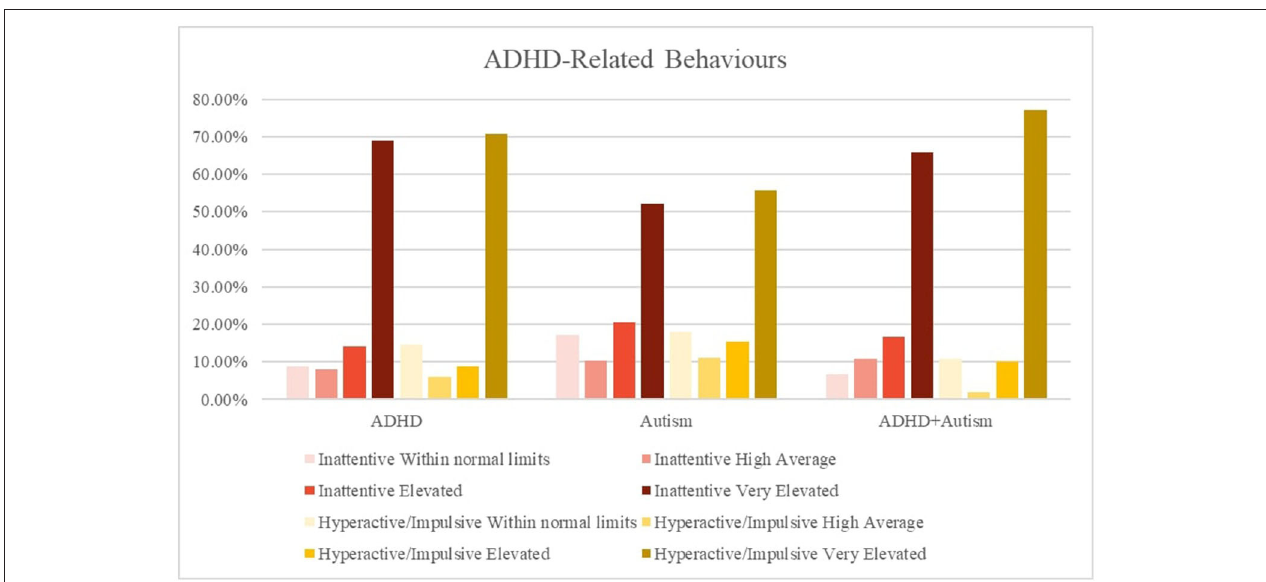
FIGURE 2 | Graphical summary of the ADHD symptoms stratified by diagnosis and hyperactive/impulsive and inattention symptoms. The CPRS:R-L descriptors relate to the standardized scoring as follows, ≤ 59 = Average/Within normal limits , 60–64 = High Average , 65–69 = Elevated , 70 ≥ = Very Elevated . CPRS = Conners’ Parent Rating Scale-Revised Long form. Inattentive, subscale; Hyperactive, Hyperactive-impulsive subscale; SRS-2, Social Responsiveness Scale-2nd Edition; RRB, restrictive and repetitive behaviors; SCI, social communication index.